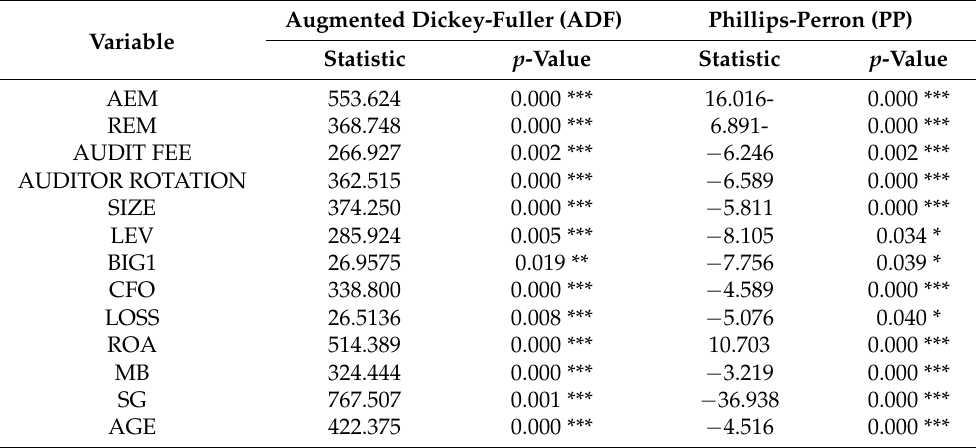
Table 2. The results of the unit root